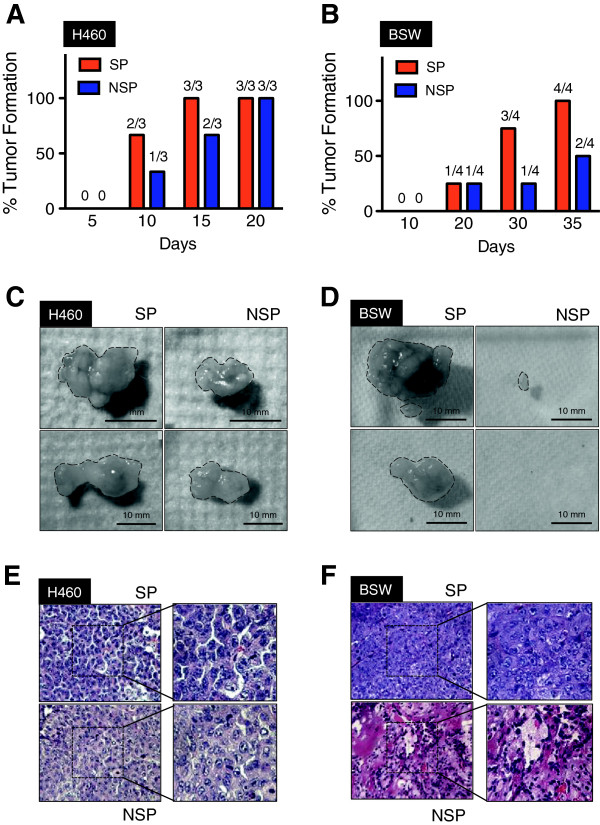
Tumorigenicity of SWCNT-induced CSC-like cells. (A, B) Growth kinetics of SP and non-SP (NSP) tumors derived from lung cancer H460 (A) and malignant transformed BSW (B) cells. (C, D) Representative SP (left) and NSP (right) tumors derived from H460 (C) and BSW (D) cells. (E, F) Representative H&E micrographs of SP and NSP tissue samples derived from H460 (E) and BSW (F) cells. Condensation of heterochromatin and multi-nucleated cells are evident in the tissue samples from SP and NSP derived from H460, and SP derived from BSW cells.